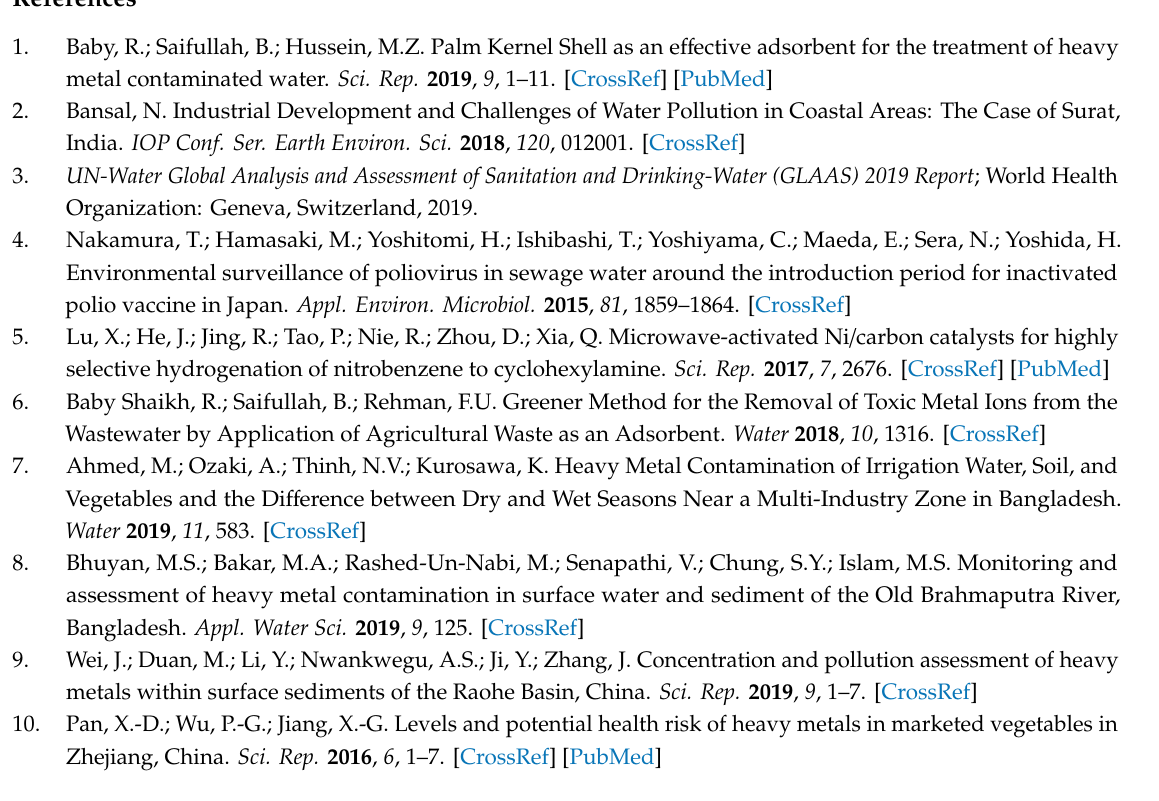
Figure S1. Kinetic graphs of Pseudo first order, Pseudo second order and parabolic di ff usion for the adsorption Cr 6 + , Pb 2 + , Zn 2 + and Cd 2 + metal ions on the AC. Figure S2. Freundlich and Langmuir Isotherms models-adsorption metal ion Cr 6 + , Pb 2 + , Cd 2 + and Zn 2 + on the activated